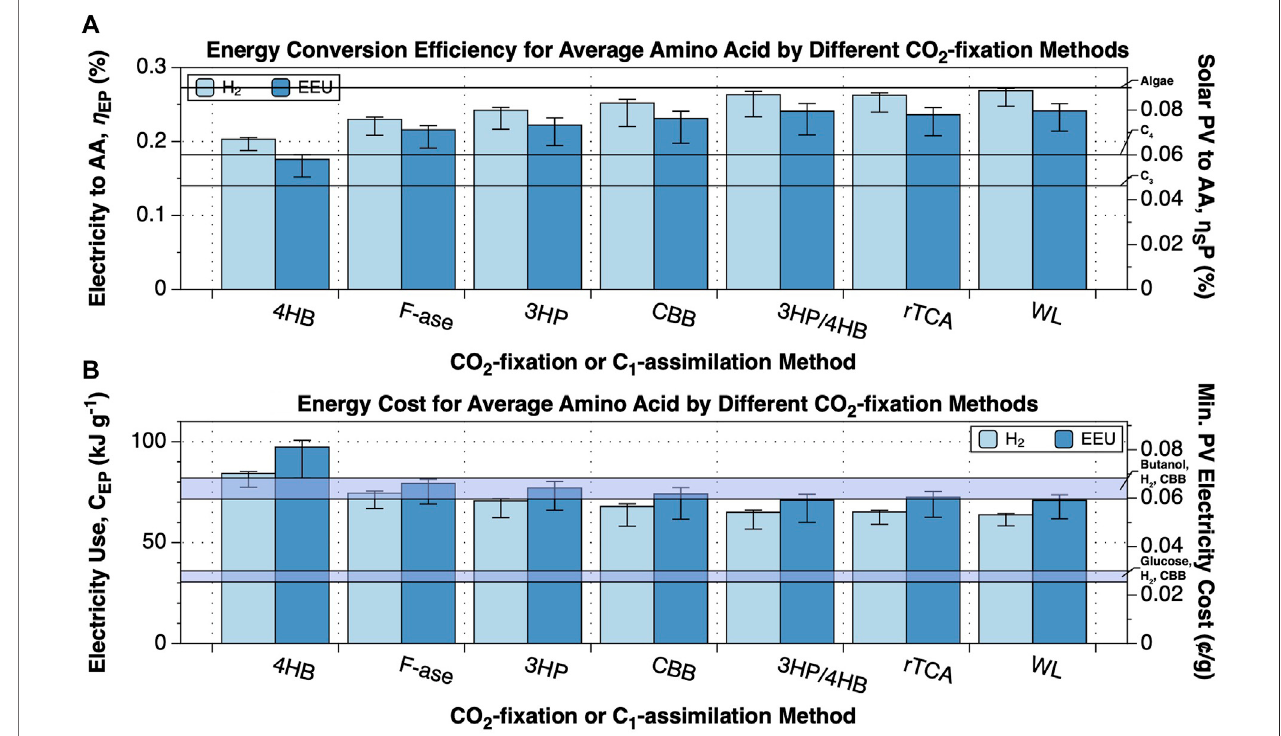
FIGURE 3 | Changing CO 2 - fi xation method can improve the performance of amino acid synthesis. The upper limit energy conversion ef fi ciency and minimum energy cost of production of an average amino acid from CO 2 or HCOO-, N 2 and electricity by electromicrobial production systems using either H 2 -oxidation or extracellular electron uptake (EEU) and one of the 6 naturally-occurring CO 2 - fi xation pathways or the synthetic Formolase formate assimilation pathway were calculated with the electrofoods package (Barstow, 2021). NADH, Fdred, and ATP requirements for synthesis of an average amino acid are tabulated in Supplementary Dataset S2 . This plot can be reproduced using the fi g-cbb_n2_to_amino_acids.py program in the electrofoods package (Barstow, 2021). 3HP, 3-hydroxypropionate cycle;3HP-4HB,3-hydroxypropionate/4-hydroxybutyatecycle;4HB,4-hydroxybutyatecycle;CBB,Calvin-Bensson-Basshamcycle;Form,Formolasepathway;rTCA, reductive TCA cycle; WL, Wood-Ljungdahl pathway. (A) Upper limit electrical and solar energy conversion ef fi ciency for an average amino acid. The left axis shows the electricity to amino acid energy conversion ef fi ciency, while the right axis shows the solar to amino acid conversion ef fi ciency, assuming the system is supplied by